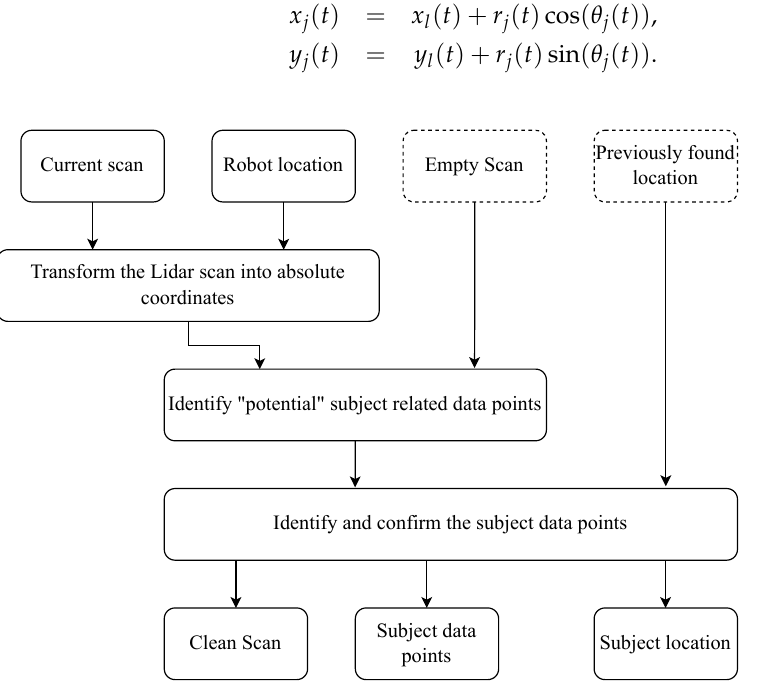
Figure 3. A simplified flowchart of the steps performed for location